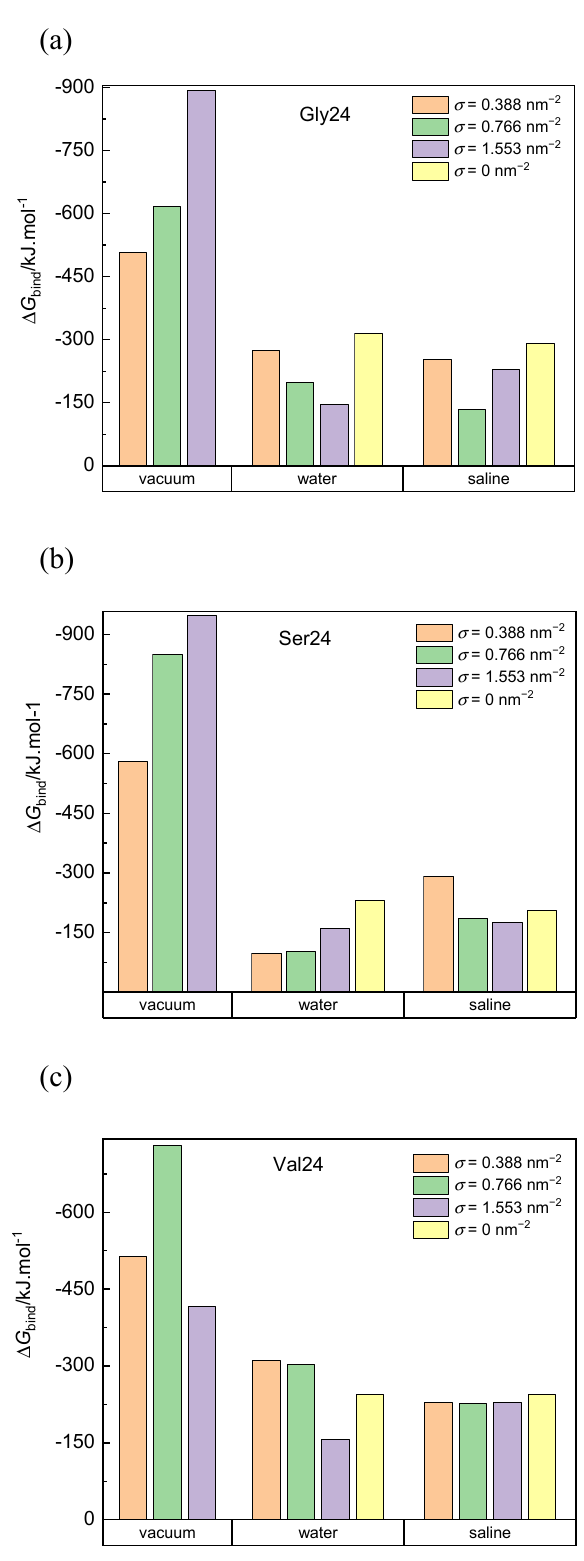
Figure 7. Binding free energy of polyglycine ( a ), polyserine ( b ), and polyvaline ( c ) interacting with pristine CNT and CNT grafted with the PEO chains at different grafting densities in a vacuum, water, and saline. Standard deviations are approximately 5% and 10% of the average values for systems in vacuum and aqueous environment, respectively.